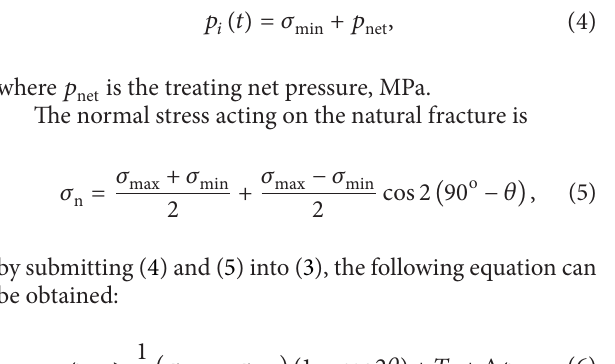
Figure 7: Experimental results of the impact of stress difference and approaching angles on fracture propagation